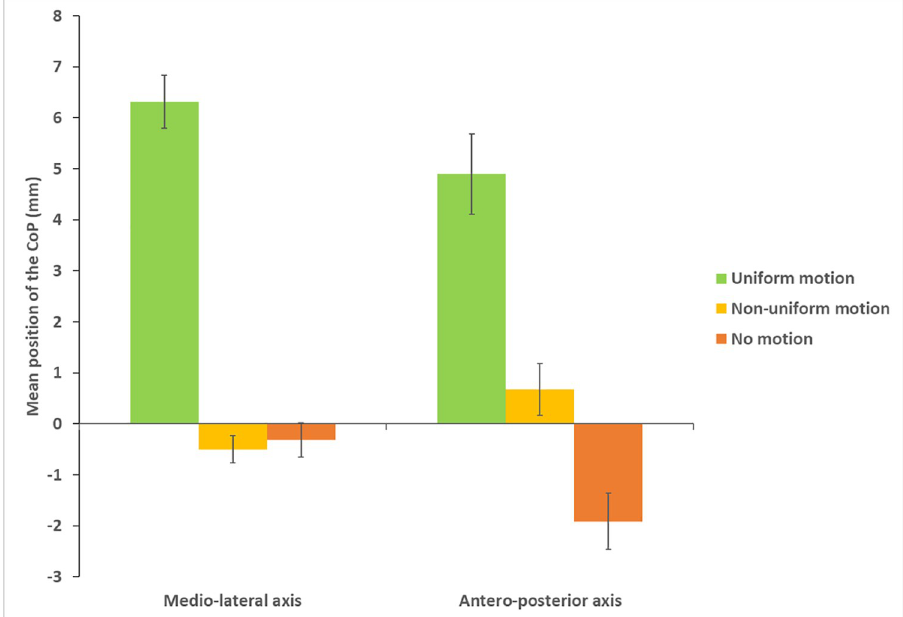
Fig 2. Mean position of the CoP on the medio-lateral and antero-posterior axis during the three visual stimulations for no motion, uniform and non-uniform motion. Positive values denote a postural deviation on the right and forward for the ML and AP axes respectively. Bars represent the standard